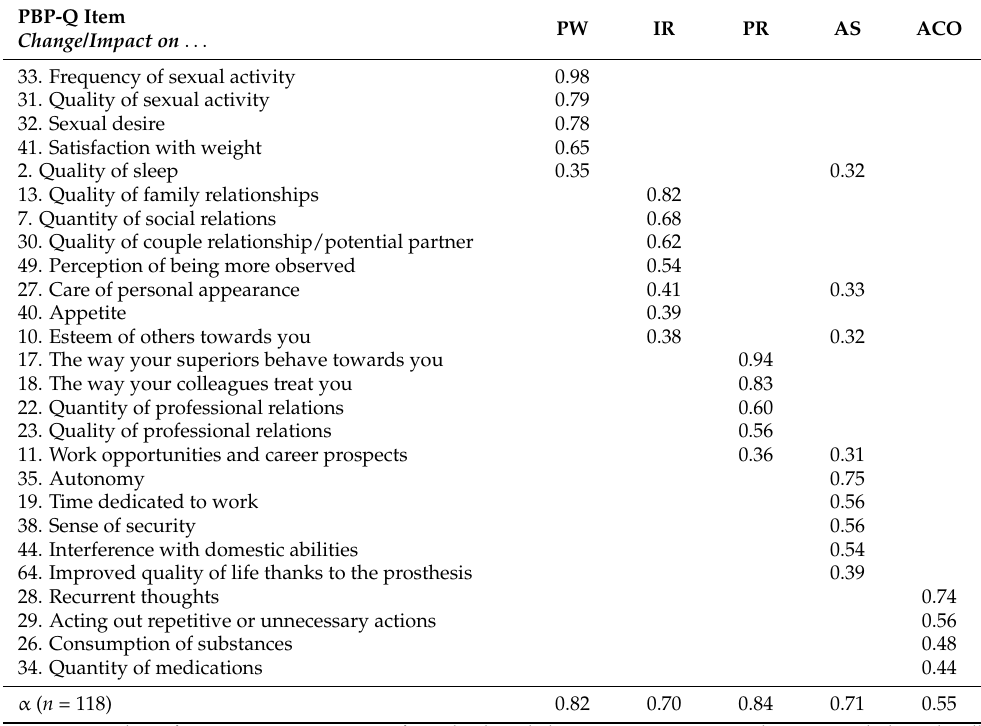
Table 1. Exploratory factor analysis (EFA) of the Prosthetic–Bionic Paradigm Questionnaire (PBP-Q; n = 118).